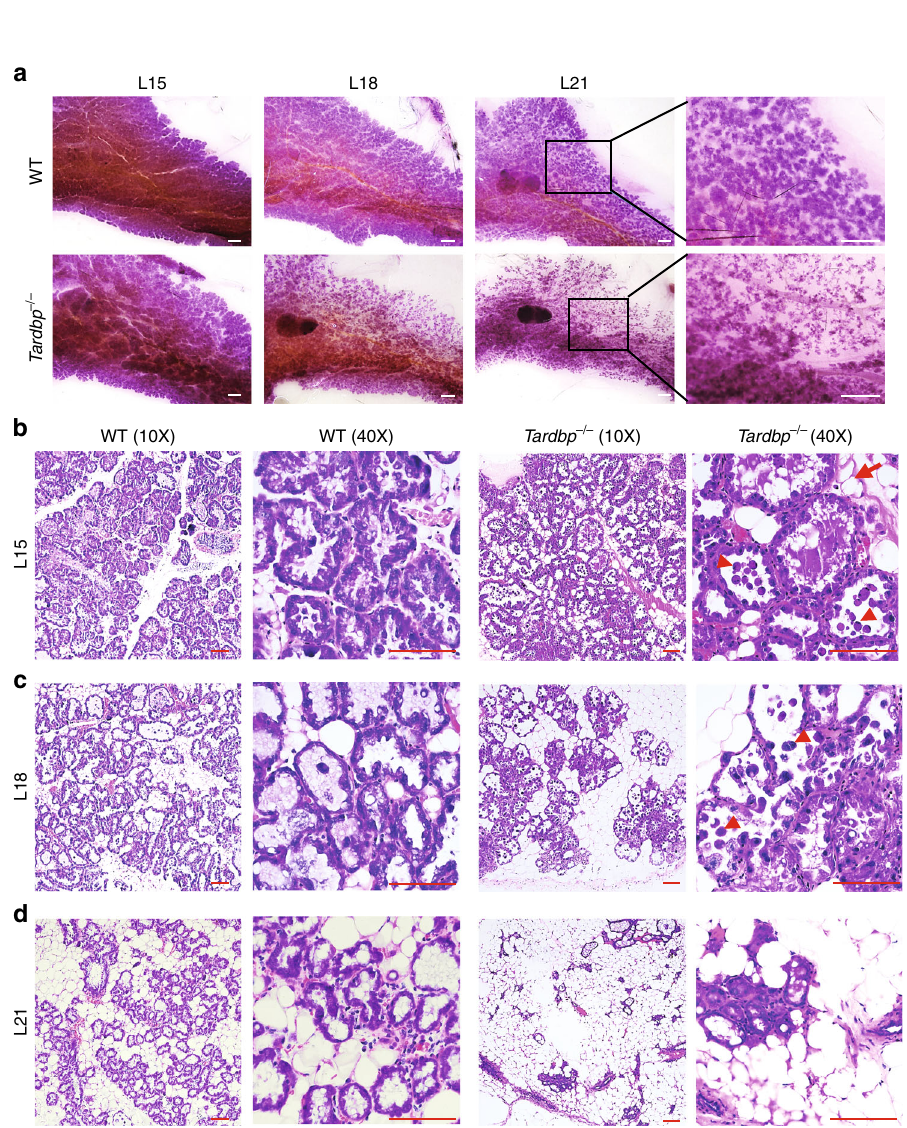
Fig. 7 TDP-43 loss results in early involution. a Whole-mount carmine staining of mammary glands of wild-type (WT) and Tardbp − / − mice at lactation day 15 (L15), L18, and L21. Magni fi ed areas are shown in black boxes. Scale bar: 1 mm. b – d Paraf fi n sections of mammary glands taken at various times during lactation and stained with hematoxylin and eosin. Arrows show milk lipid droplets and arrowhead shows shedding cells. Scale bar: 100 μ